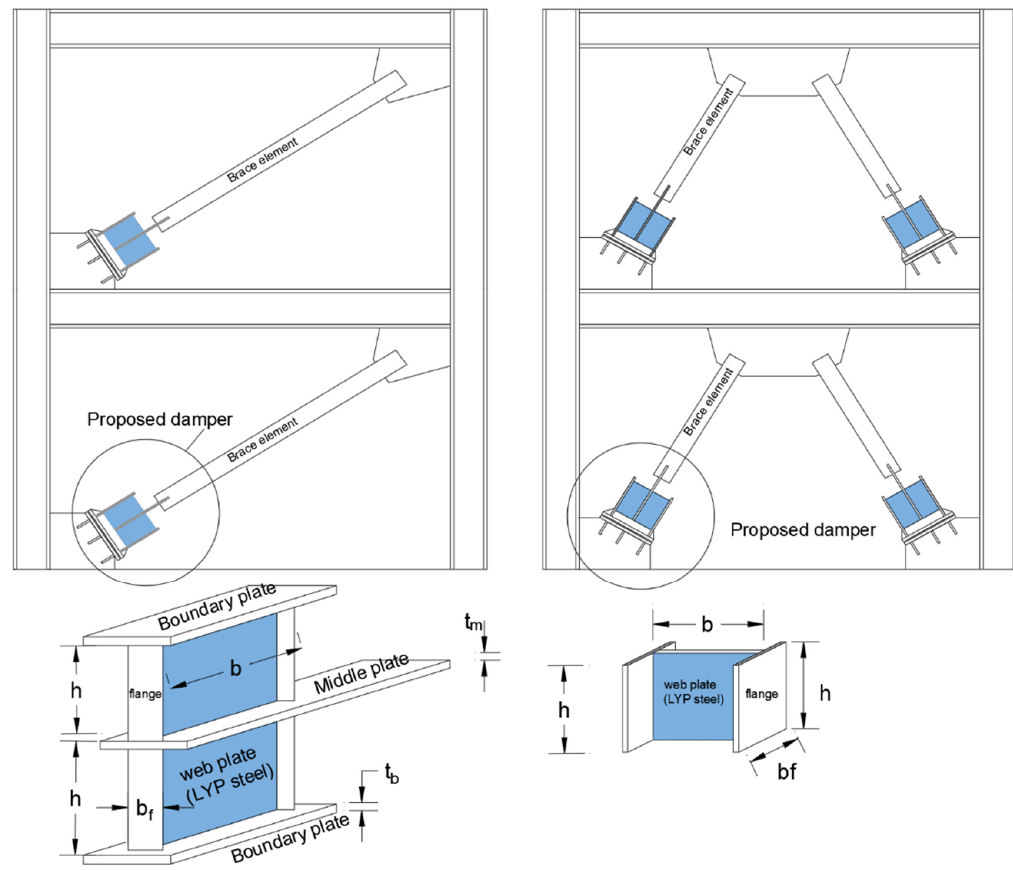
Figure 1. Proposed damper.